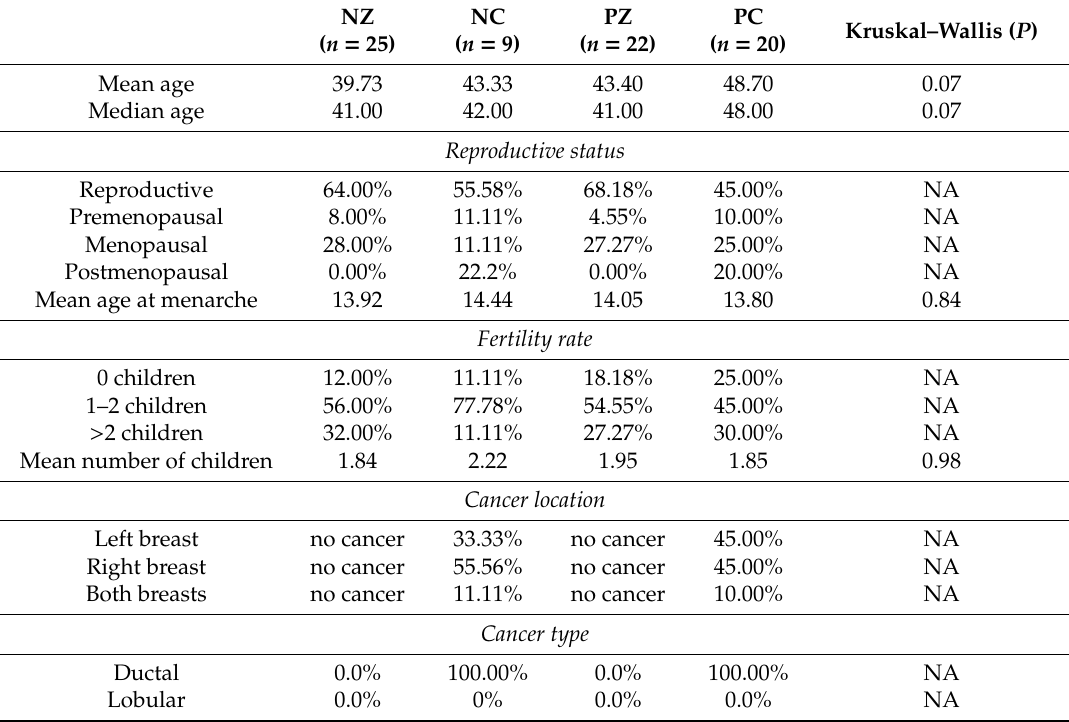
Table 1. Characteristics of the analyzed